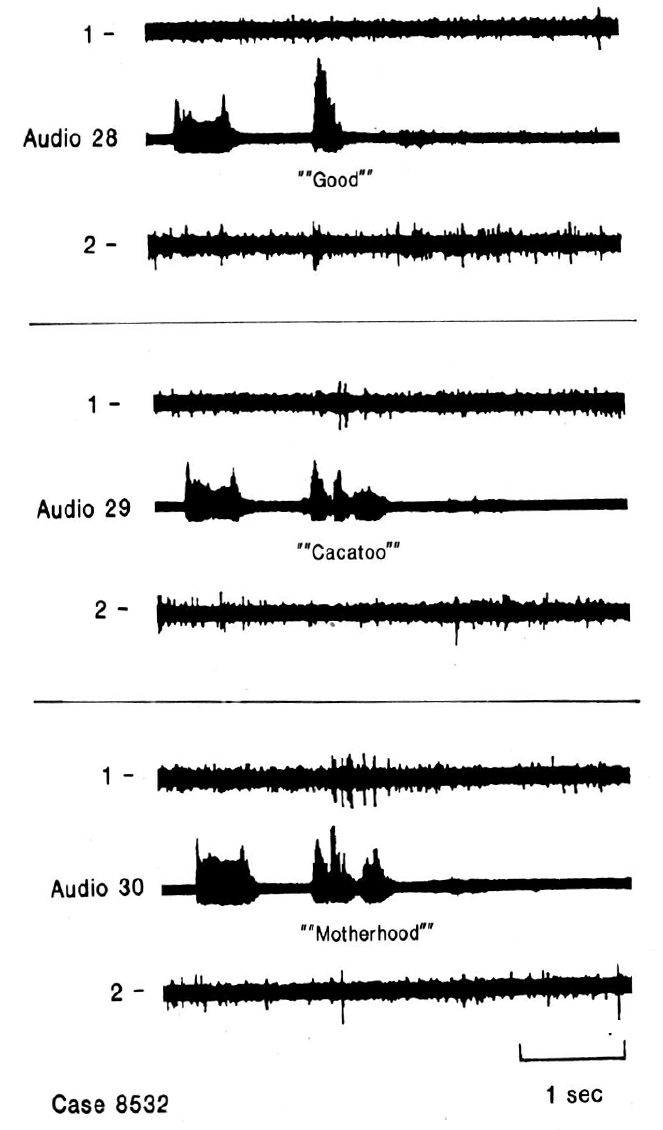
Figure 3. Single neuron activity related to second and subsequent syllables. Recordings from two electrodes at different depths in the same region of nondominant superior temporal gyrus during word listening. Neuron in channel 1 responds only to second and subsequent syllables of multisyllable words and not to single syllable words. Creutzfeldt and Ojemann, unpublished data